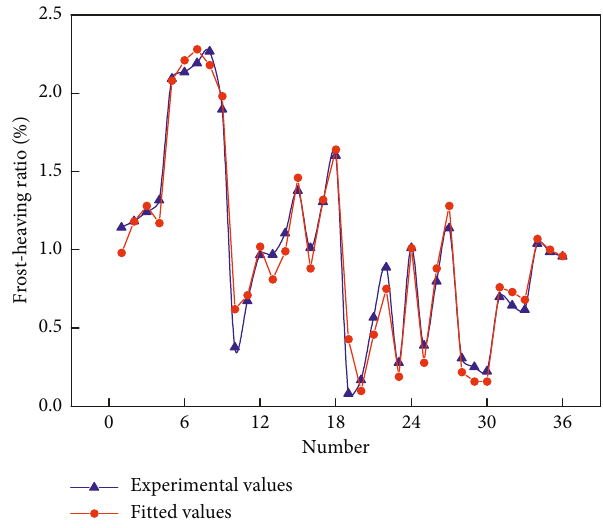
Figure 13: Contrast of experimental and fitting values of frost- heaving